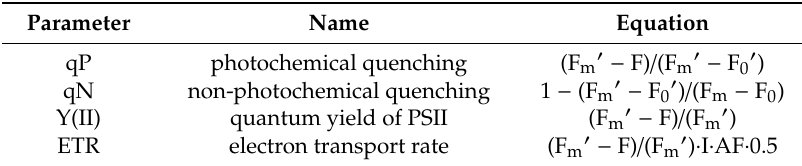
Table 1. Fluorescence parameters calculated from PAM fluorometry. The equations contain the minimum (F 0 ) and the maximum (F m ) fluorescence yields, the apparent (F s ) and maximum (F m (cid:48) ) values of fluorescence, the irradiance value (I) and the empirical absorption factor (AF = 0.84). For more information the reader is directed to the cited